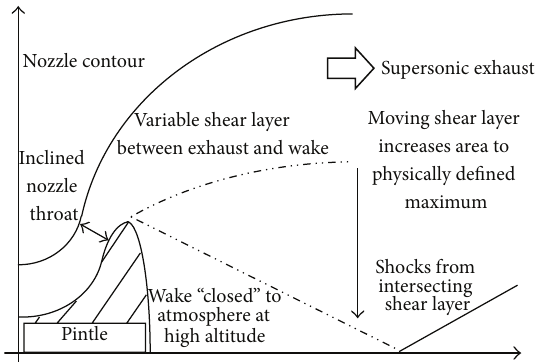
Figure 2: Half diametric cross section of the expansion-deflection nozzle behavior in closed mode.